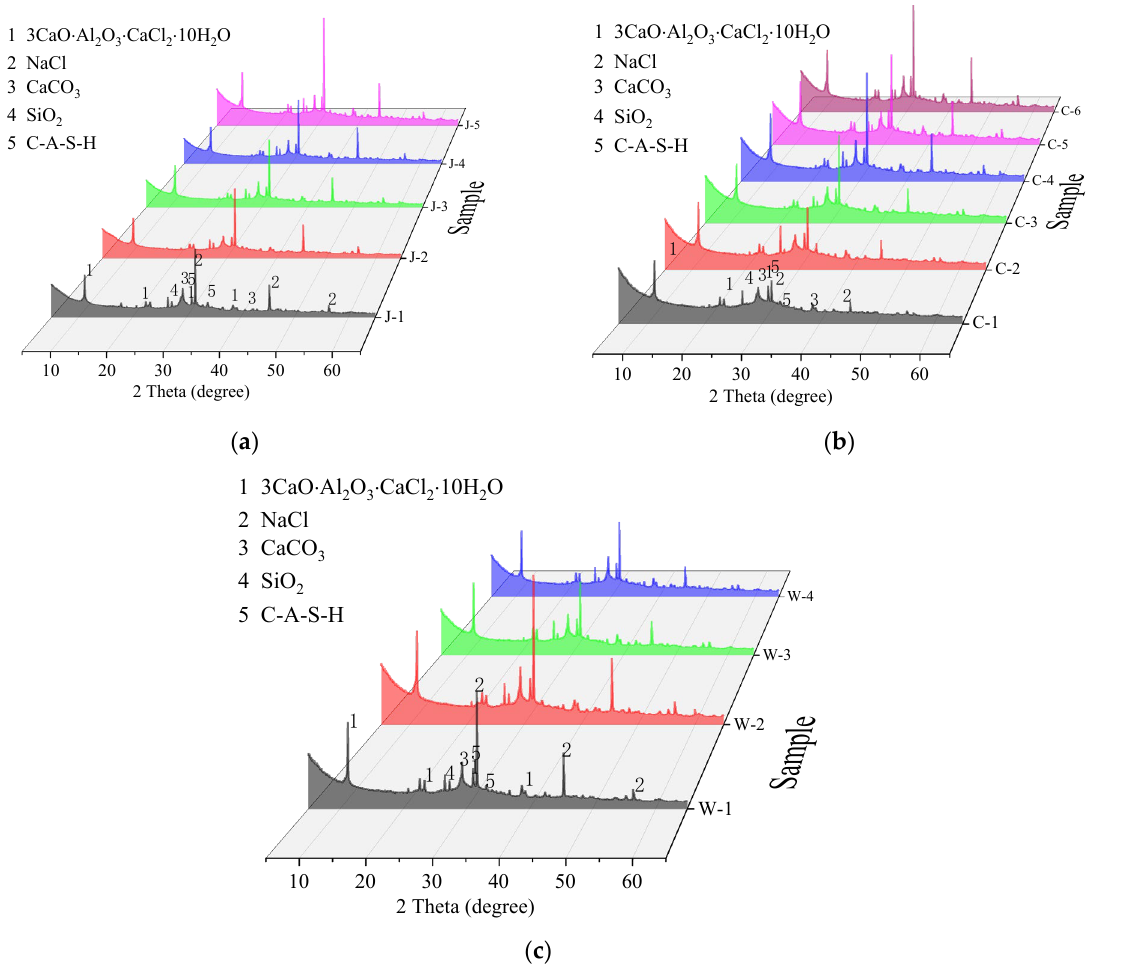
Figure 3. XRD patterns ( a – c ) of all 28 d net slurry specimens at different groups.